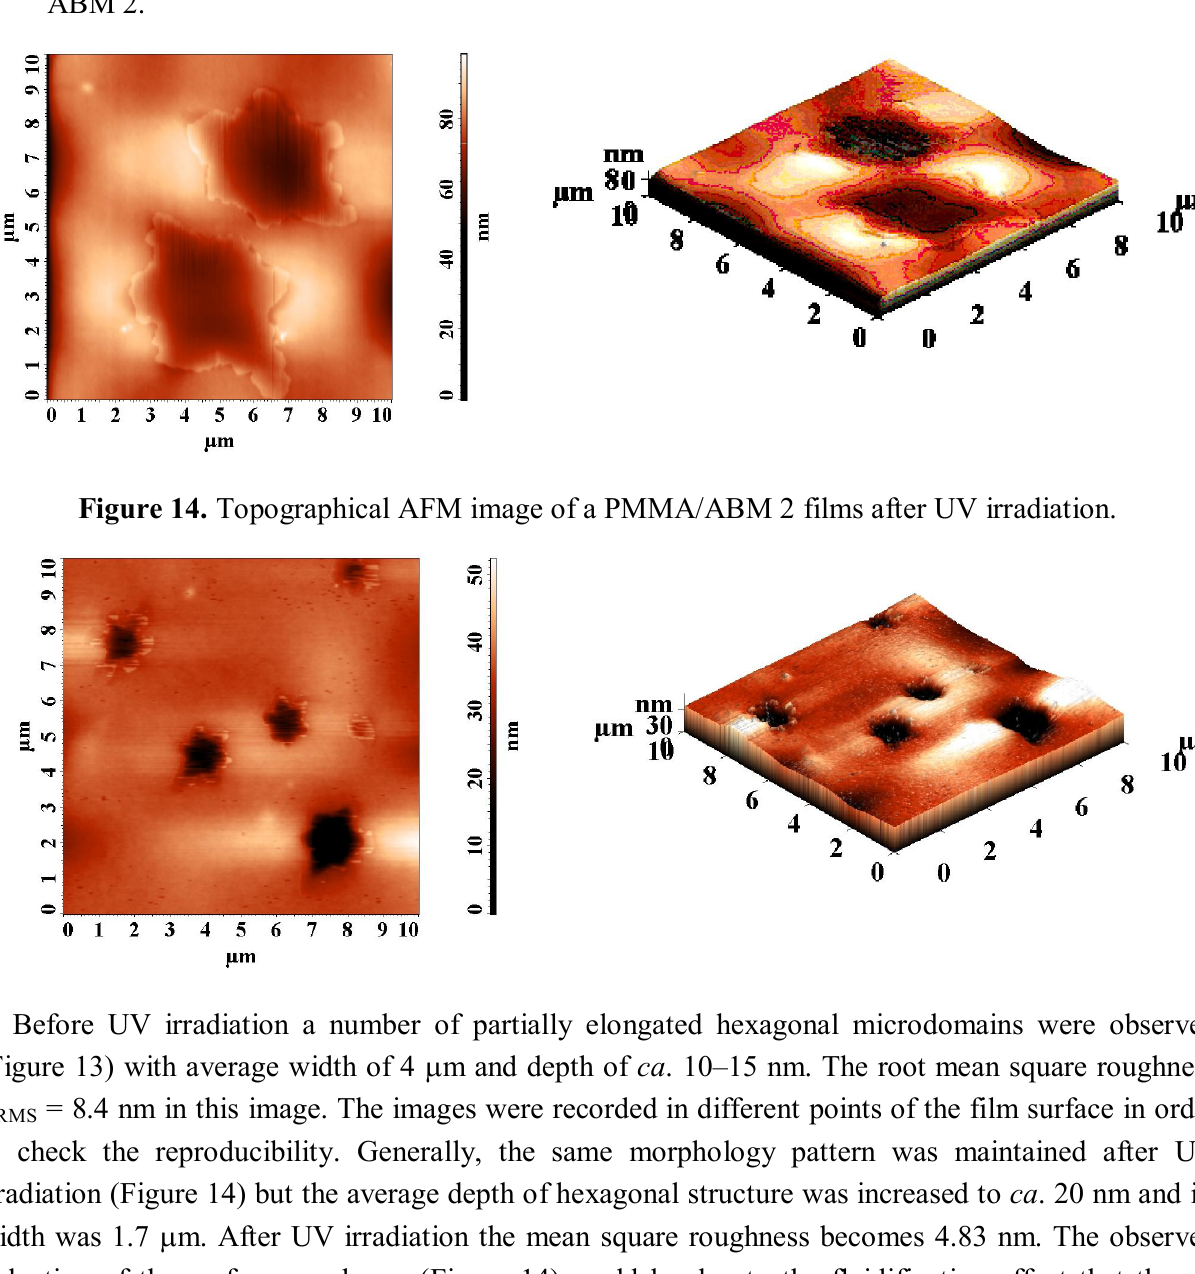
Figure 13. Atomic force microscopy images of PMMA film containing azobismaleimide ABM 2.